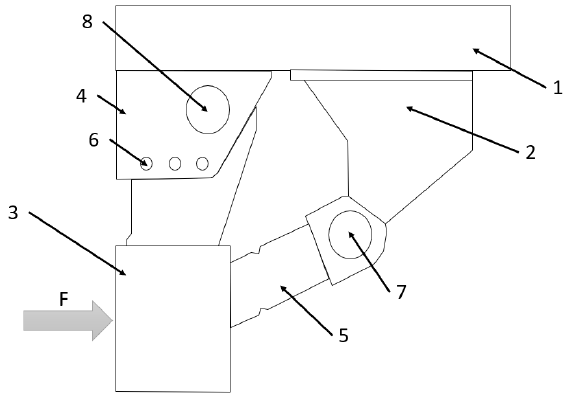
Figure 16. View of the RUPD with an energy-absorbing element described in Patent Application No. Patent EP1373025B1. 1 — Vehicle frame; 2 — Support frame; 3 — Impact element with RUPD guard bar; 4 — Support member for impact element; 5 — Energy-absorbing element; 6 — Locking element; 7, 8 —